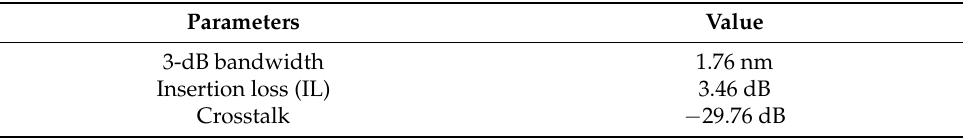
Figure 10. Testing system for the spectrum measurement of the fabricated AWG. Table 2. Detailed performance measurement of our